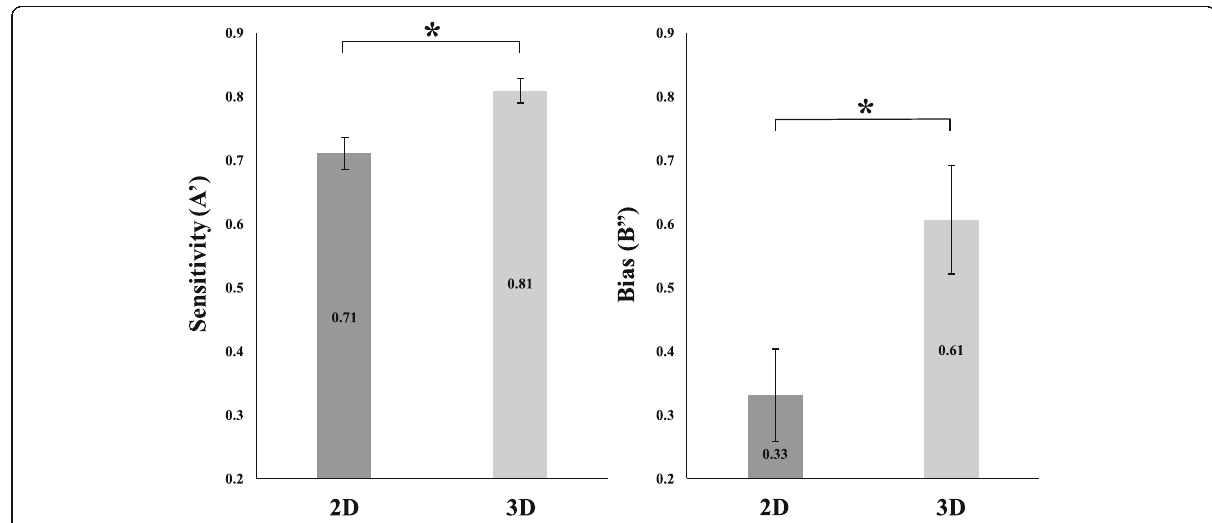
Fig. 4 Sensitivity (A ’ ) and bias (B ” ) measures for 2D- and segmented-3D-search displays in Experiment 2. The asterisks indicate a significant difference between A ’ and B ” between 2D and segmented-3D displays with a greater A ’ and B ” in segmented-3D